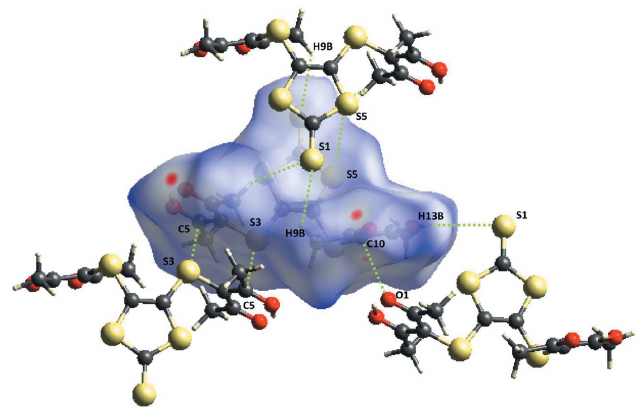
Figure 3 Hirshfeld surface of the title compound mapped over d norm with the four main intermolecular contacts in the crystal lattice shown.